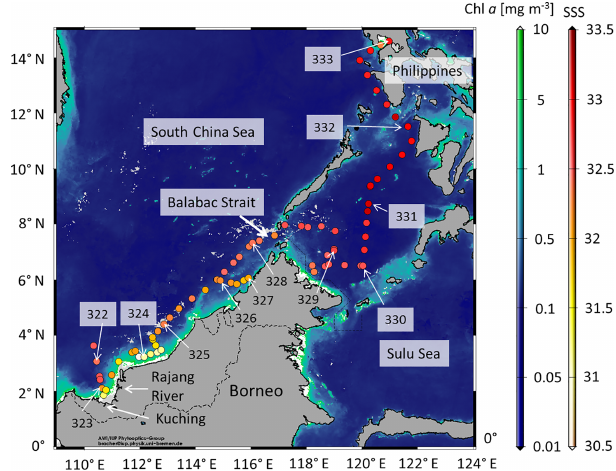
Figure 1. Cruise track (17–29 November 2011) showing salinity in the surface seawater at each point when an underway measurement was conducted. Numbers show the day of the year and the arrows the location when a day started. Background colors show chloro- phyll a (Chl a ; level-2) data from the MERIS satellite sensor (on- board Envisat) using the polymer product (Steinmetz et al., 2011). Note that the Chl a concentrations are shown on a logarithmic